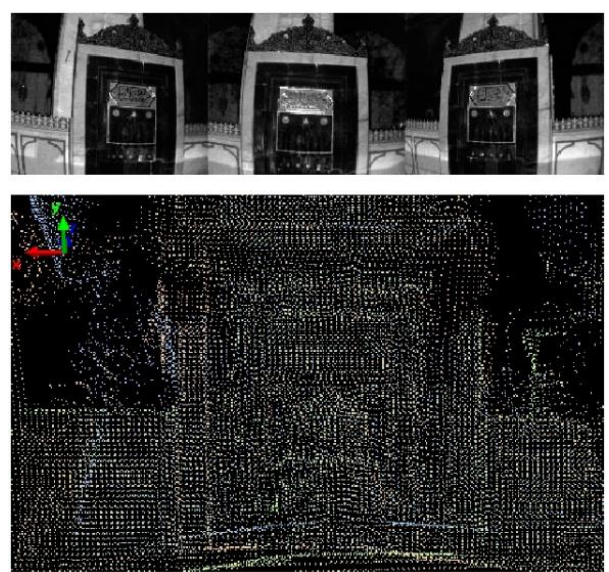
Figure 9. The Mihrab in Masjid was measured from three stations with a SR4000 camera. The registration of the measurements relation to the first point cloud was applied by ICP. Intensity images ( top ), and combined point clouds ( below ).